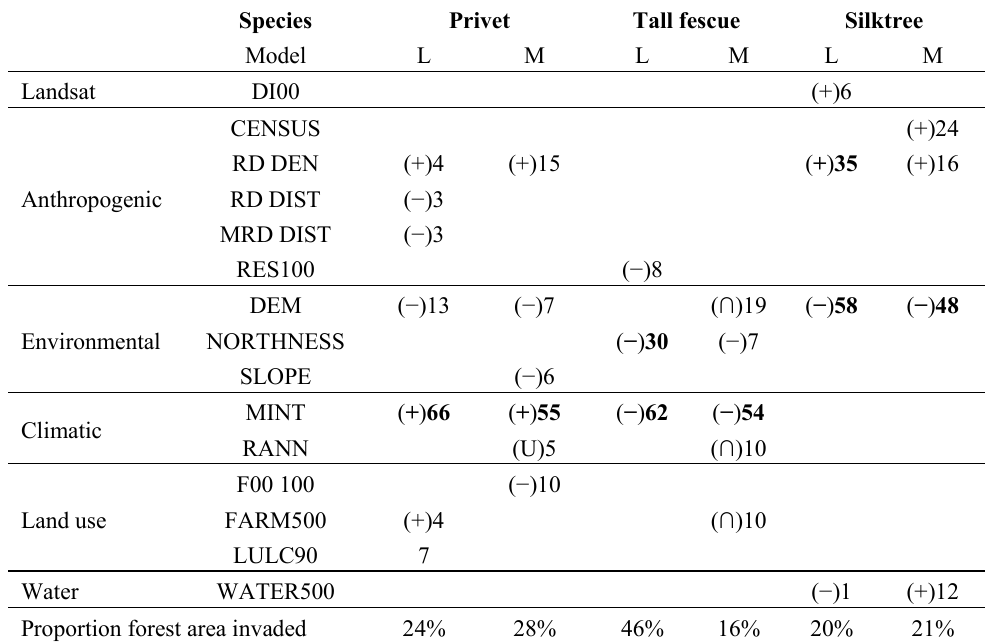
Table 4. Contribution of variables to the final composite models ( − , negative; +, positive; ∩ or U for bimodal relationship), dominant variables given in bold (>25%). L = logistic regression; M = MaxEnt. Species Privet Tall